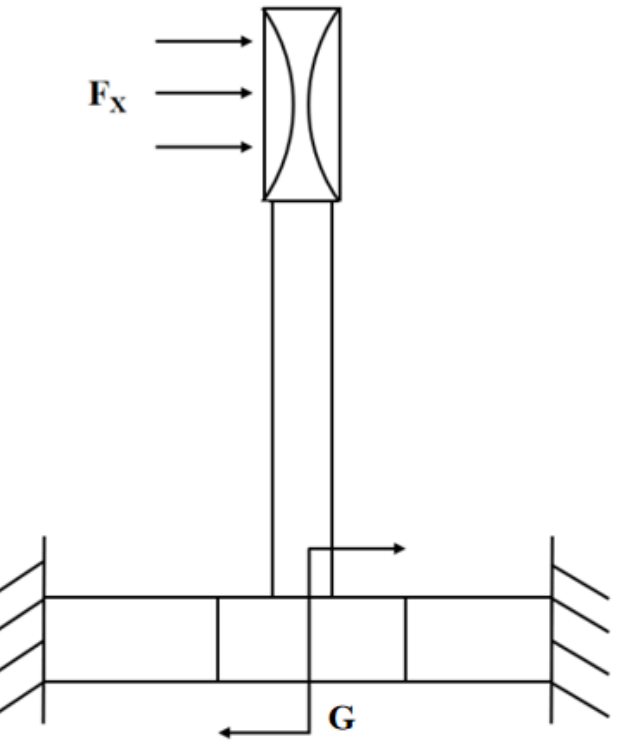
Figure 2. Mechanical analysis of microstructural model. Table 1. Dimensions and